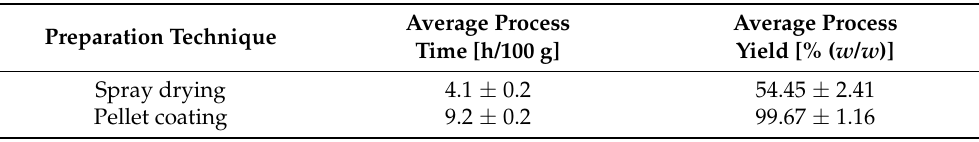
Table 3. The resulting process characteristics of the SD and PC processes. The mean value is shown with the standard